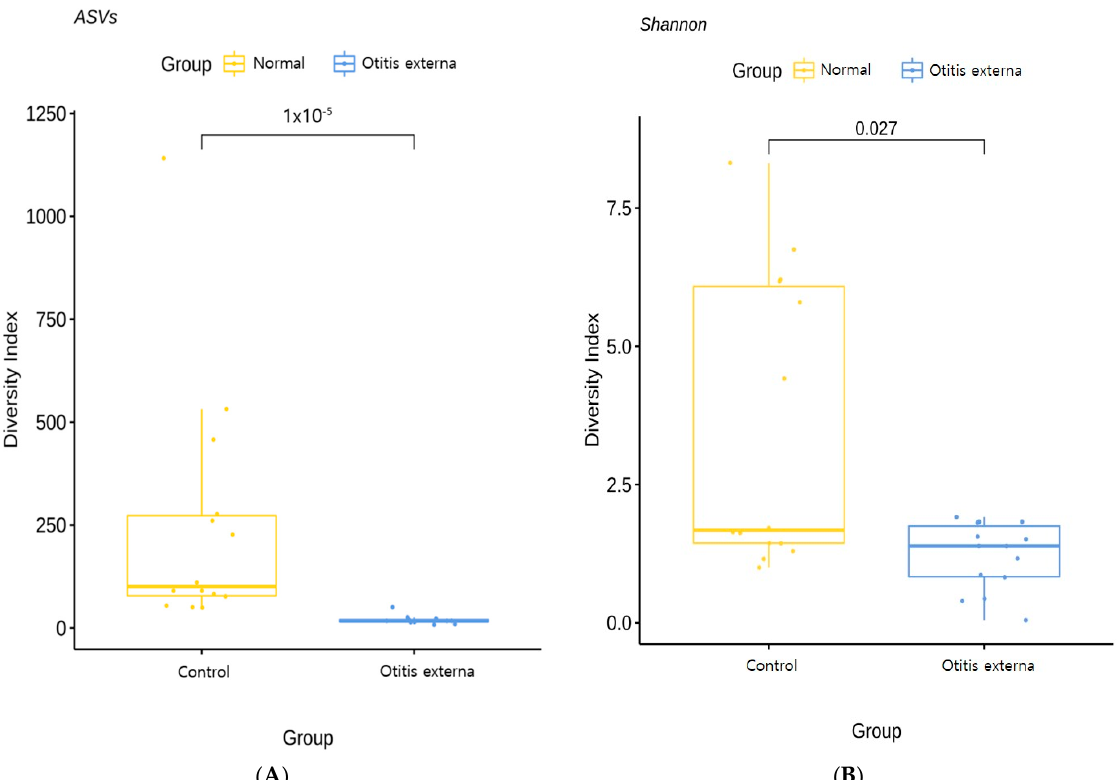
Figure 1. Box plot of the ASV-based analysis ( A ) and Shannon index values ( B ) for diversity. Boxes represent second or third quartiles. ASV (amplicon sequence variant): inferred single DNA sequences recovered from a high-throughput analysis of marker genes.